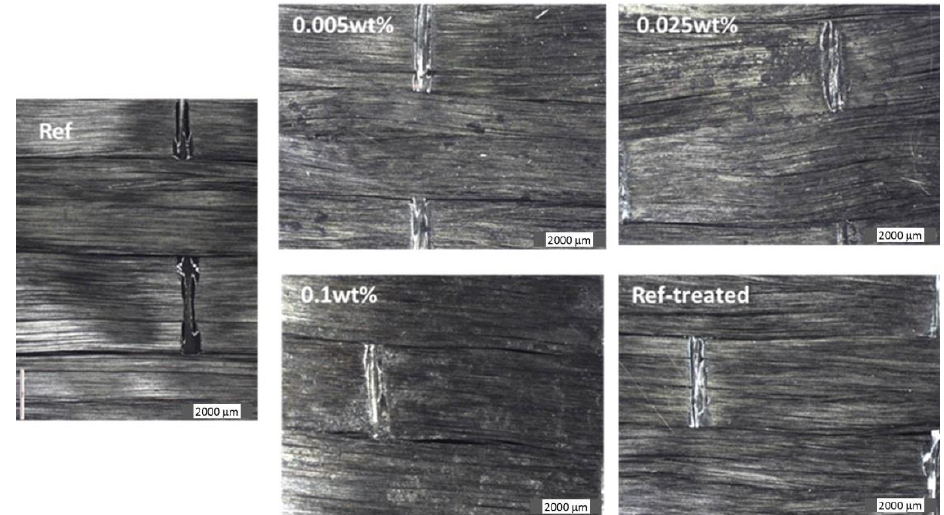
Figure 7. Micrograph of 0.1 wt% CNT suspension-treated CF fabric short beam shear specimen after the test. The ( Bottom ) image shows an overview of the part of the specimen. The ( Upper ) images indicate the fiber kinking formed during the failure.